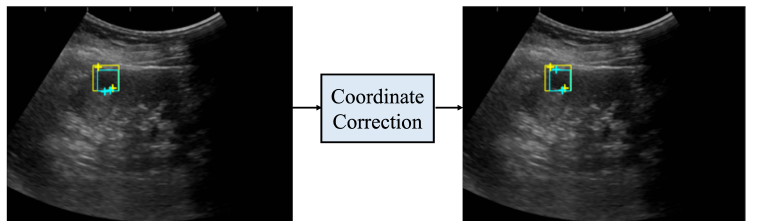
Figure 6. Coordinates before and after coordinate correction. The yellow rectangle is the true bounding box, the light blue rectangle is the bounding box predicted by the renal cyst detection model, the yellow crosses are the true salient landmark coordinates, and the light blue crosses are the salient landmark coordinates determined from the saliency map output by the salient landmark position prediction model. The left side of the figure shows the coordinates before correction and the right side shows the coordinates after correction. After correction, the distance between the two salient landmarks of the prediction is closer to the distance between the two salient landmarks of the true